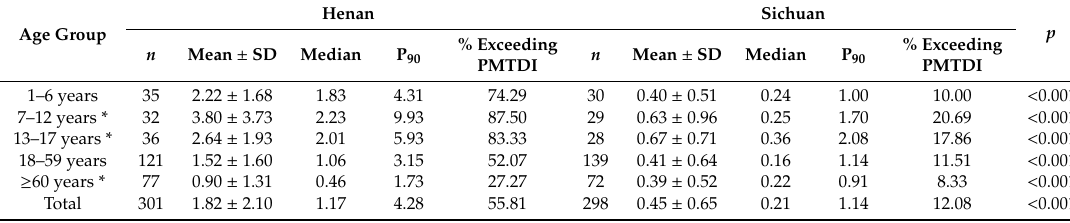
Table 2. Estimated dietary DON intakes of the